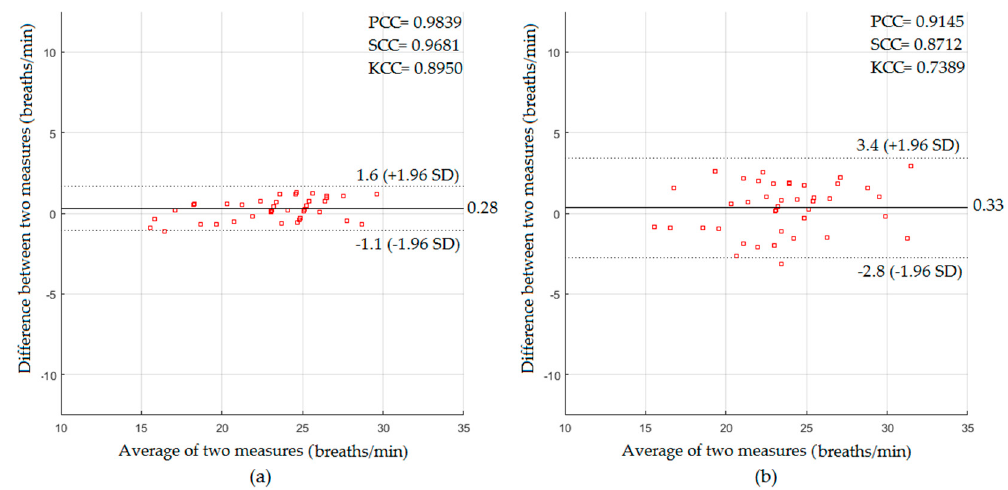
Figure 8. The statistics of RR measurements obtained in a well-lit environment for participants ( a ) without a blanket; ( b ) with a blanket.